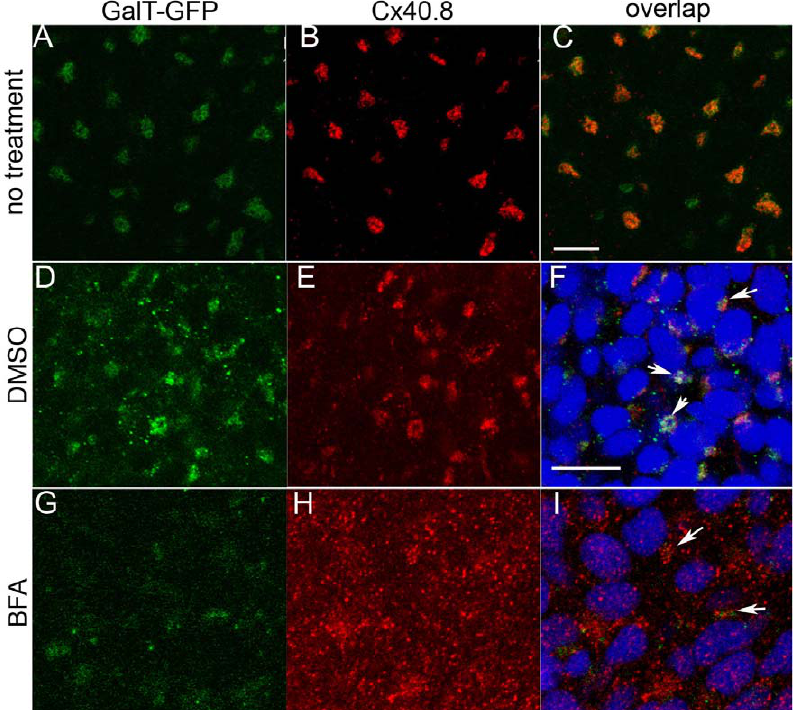
Figure 3. Cx40.8 co-localizes with the GalT-GFP transgene found in the Golgi during regeneration. (A–C) Co-localization in untreated regenerating fins. (D–F). Co-localization in regenerating fins treated with 0.1% DMSO carrier. (G–I) Fins injected with10 m g/ml BFA/0.1% BFA to disrupt the Golgi show dispersal of both Cx40.8 and GalT-GFP signals. In D-I, nuclei (blue) are stained with TO-PRO3 detected in the far red channel. Arrows point to areas of overlap in F (intact Golgi) and I (remnants of intact Golgi). Scale bars in C and F, 10 m